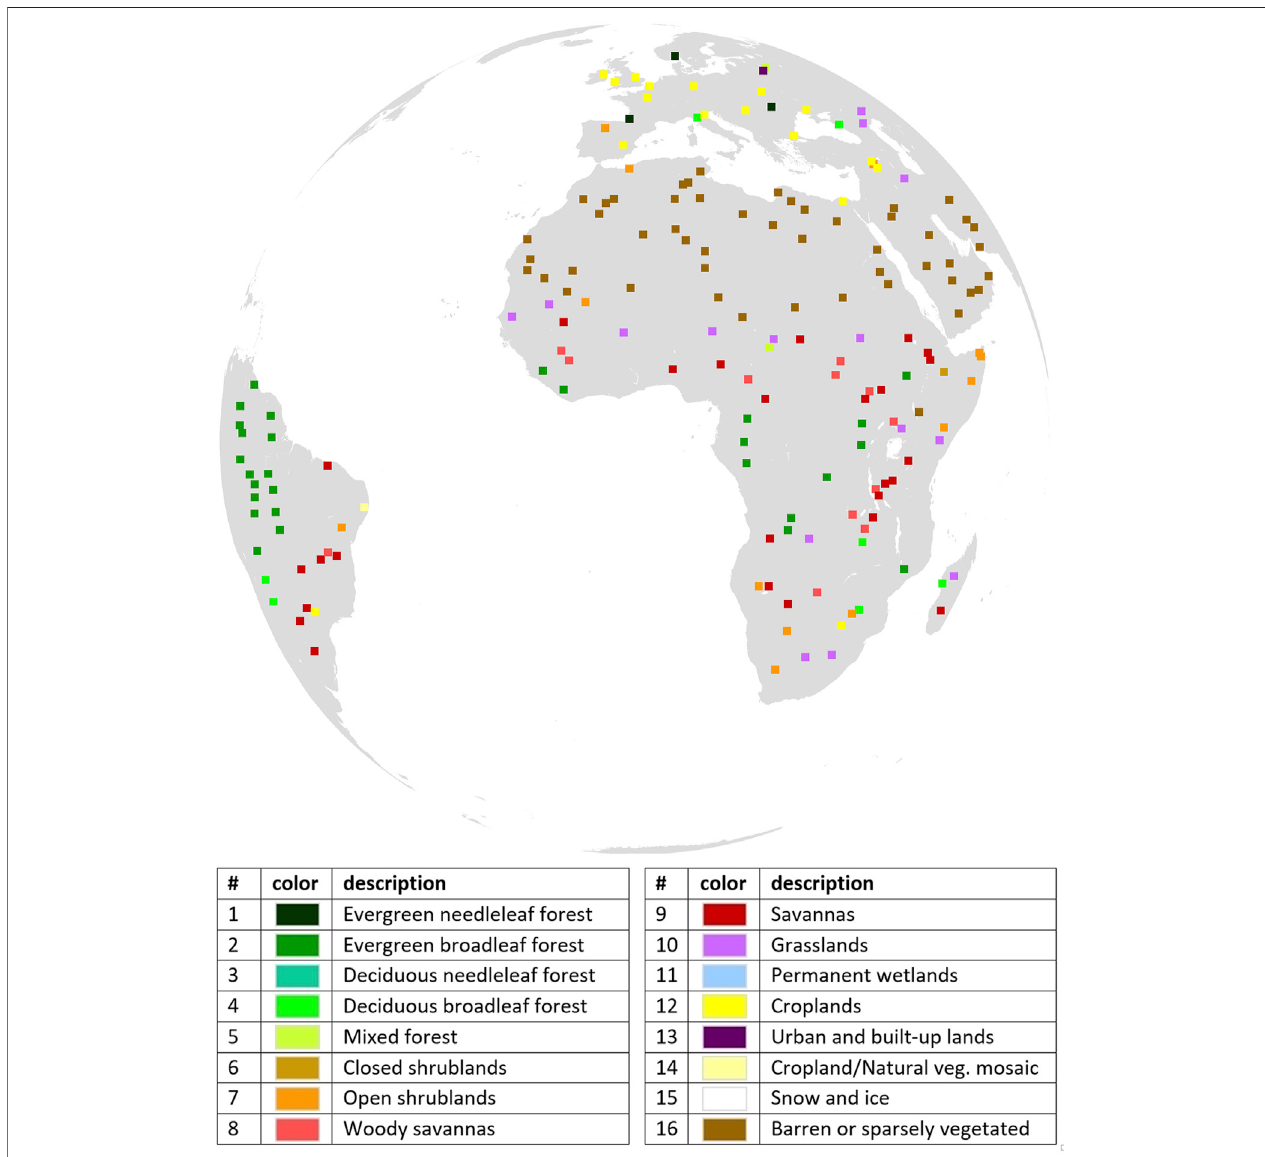
FIGURE 2 | Location of BELMANIP sites and their corresponding IGBP class.